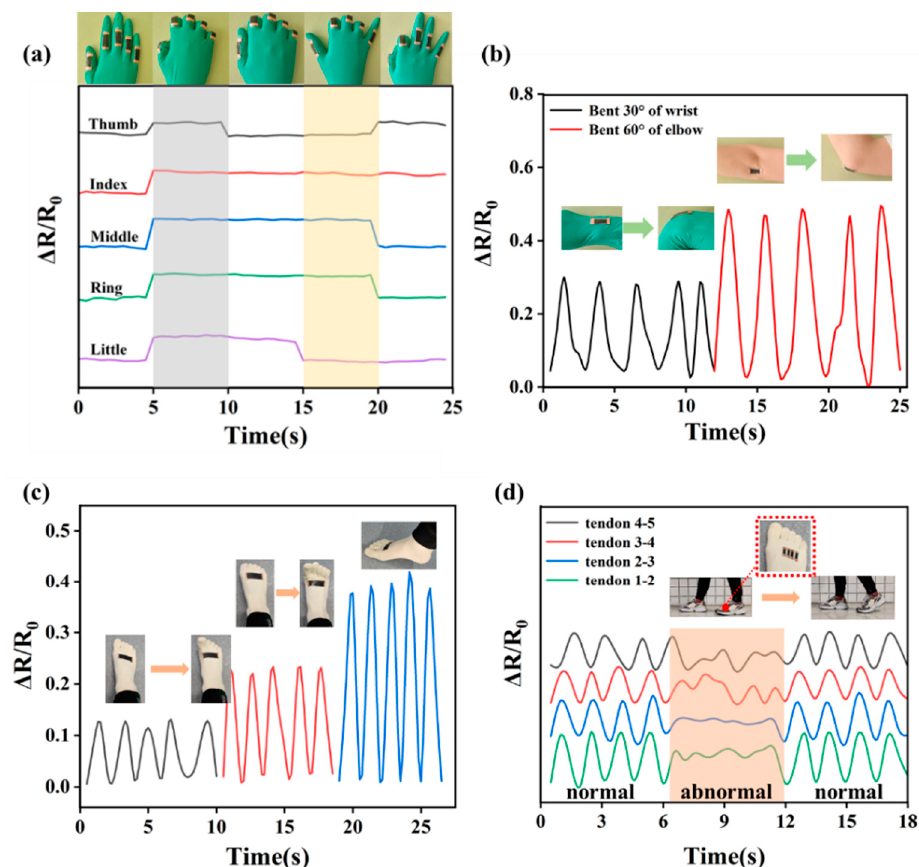
Figure 8. Applications of DEF/c-MWCNTs/PPy sensor in monitoring the joints motions: the RRV signal of warp strain sensor for monitoring ( a ) fingers joints motions and ( b ) wrist and elbow joints motions. The RRV signal of weft strain sensor for monitoring ( c ) toes motions and ( d ) walking. Similarly, the weft sensor (6 cm × 2 cm) was attached to the tester’s instep to record